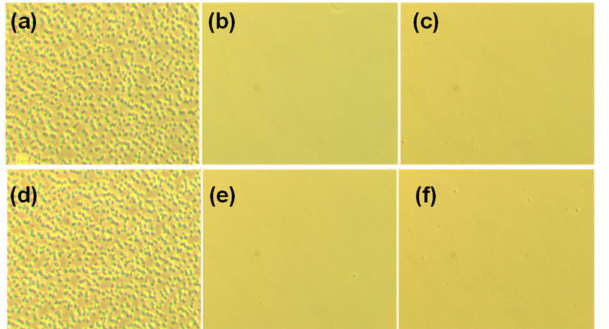
Figure 4. Optical microscope photos of PTPA-C6/PS blend (1:1) ( a , d ), PTPA-C6/PS- co -5PHS blend (1:1) ( b , e ), and PTPA-C6/PS- co -10PHS blend (1:1) ( c , f ) after spin-coating on glass and being annealed at 25 ◦ C ( a – c ) and 100 ◦ C ( d – f